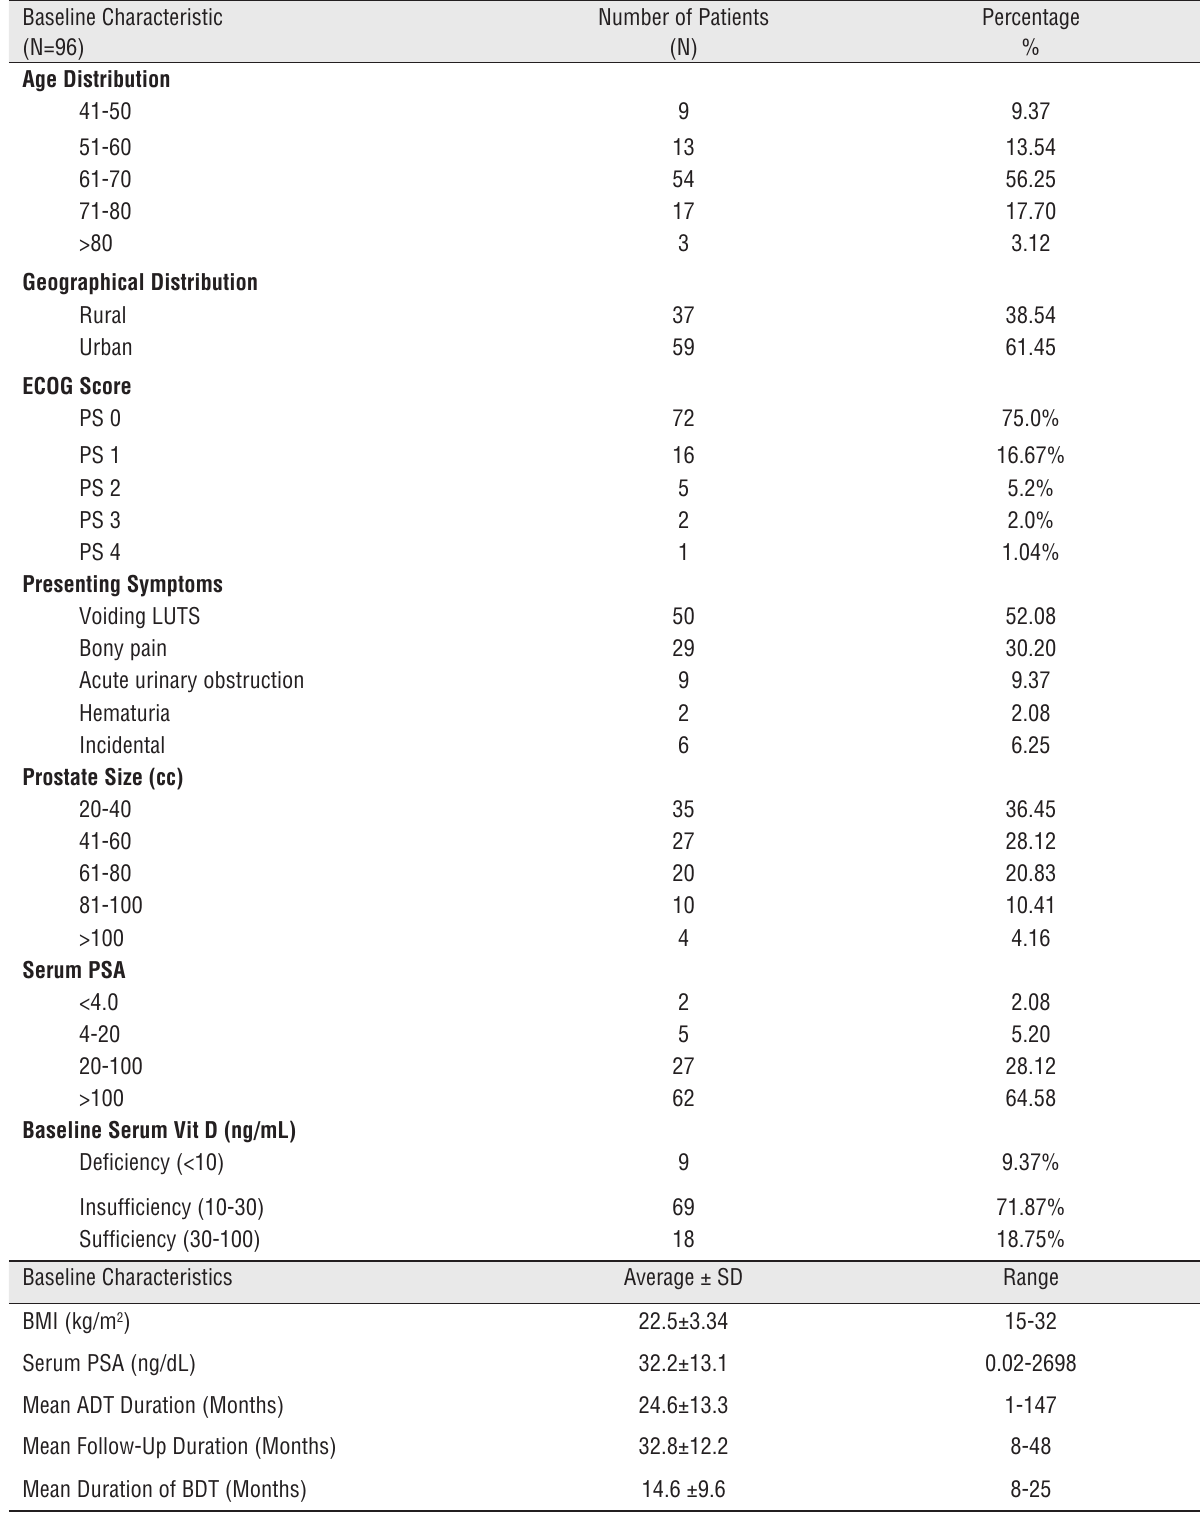
Table 1 - Demographical data and baseline characteristics of prostate cancer patients